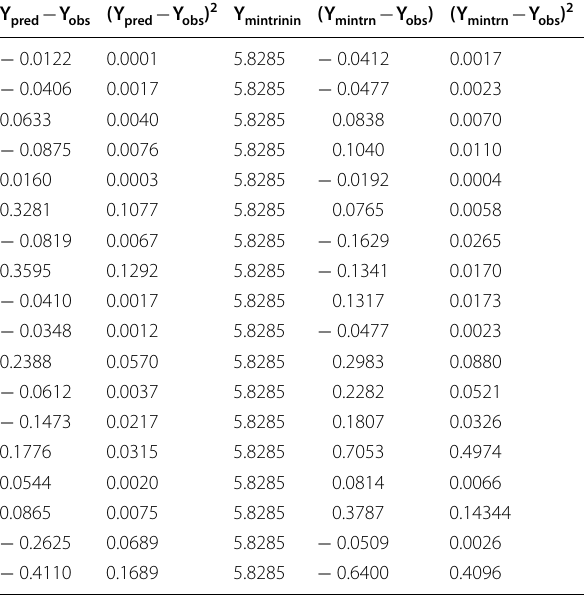
Table 8 Continuation of the external validation of the